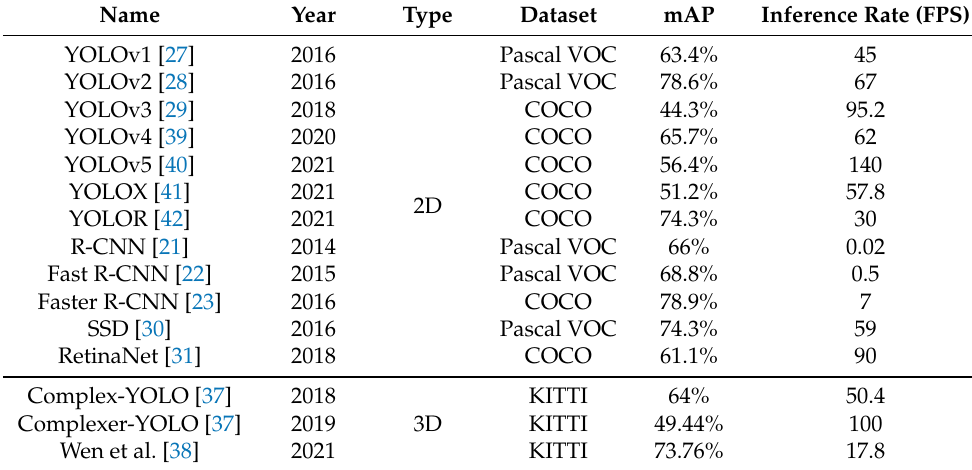
Table 1. 2D and 3D object detector models and their